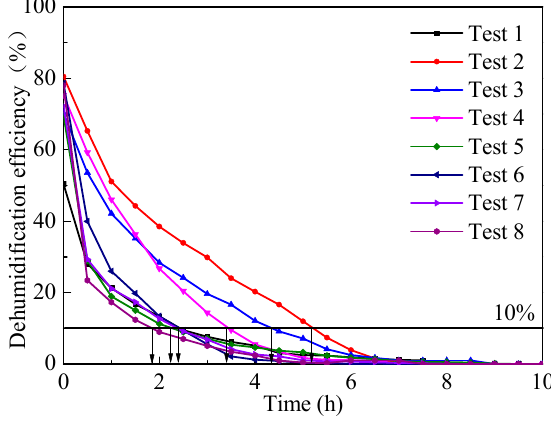
Figure 8 indicated the variation of dehumidification efficiency with time in different test conditions.